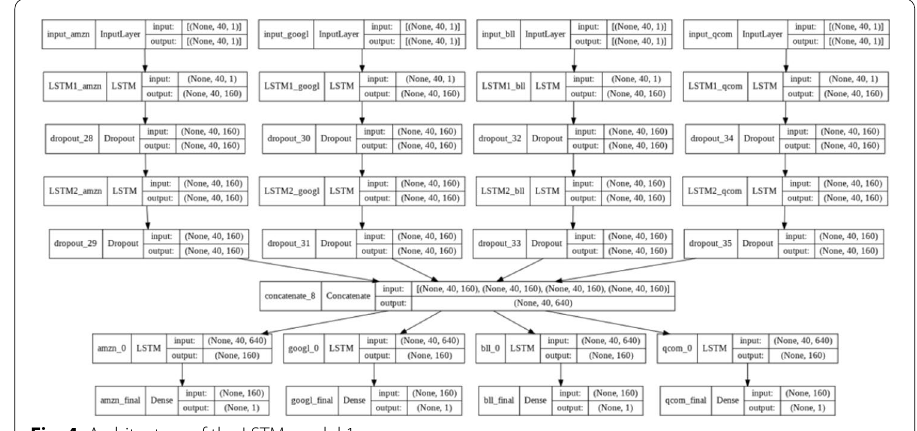
Fig. 4 Architecture of the LSTM model 1